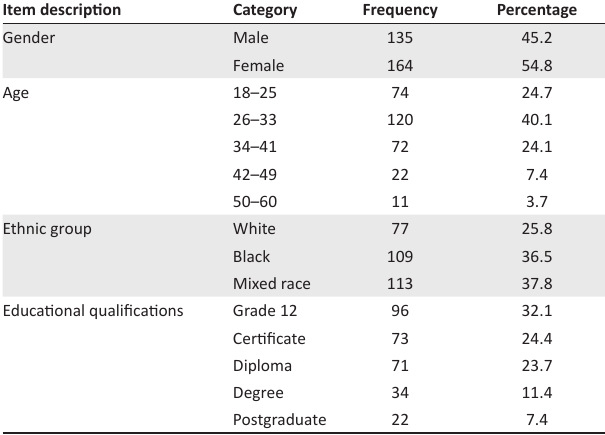
TABLE 1: Participant